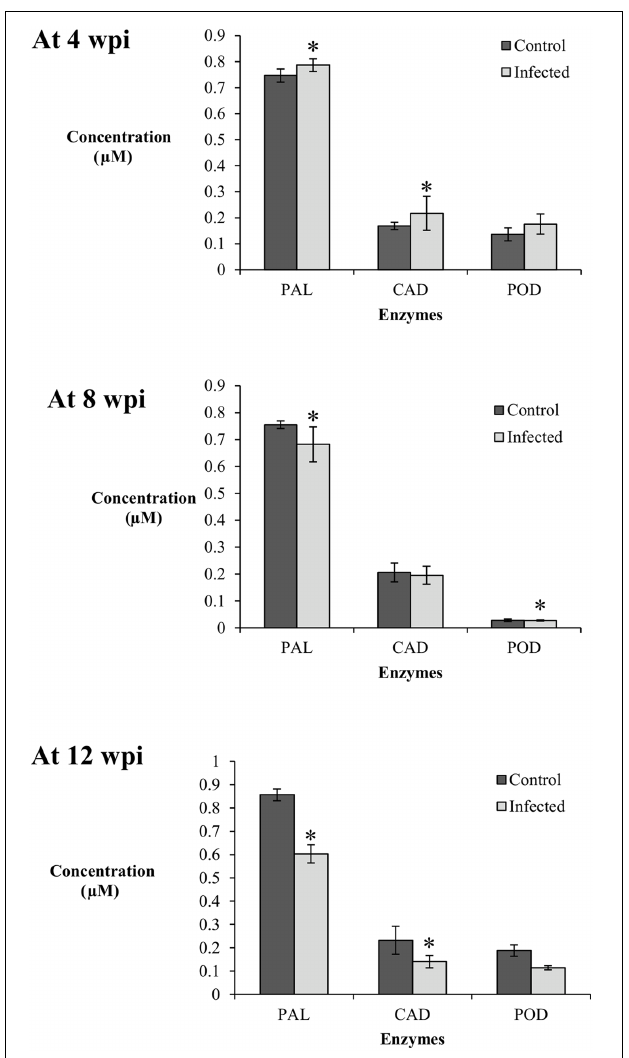
FIGURE 4 | Enzyme activity in the root tissues (0.01 g) of control (non-inoculated) and infected ( Ganoderma boninense -challenged) oil palm seedlings at 4, 8, and 12 wpi; phenylalanine ammonia lyase (PAL), cinnamyl alcohol dehydrogenase (CAD), and peroxidase (POD). Bars represent mean ± standard deviation of four biological replicates. Asterisk indicates significant difference at p < 0.05.